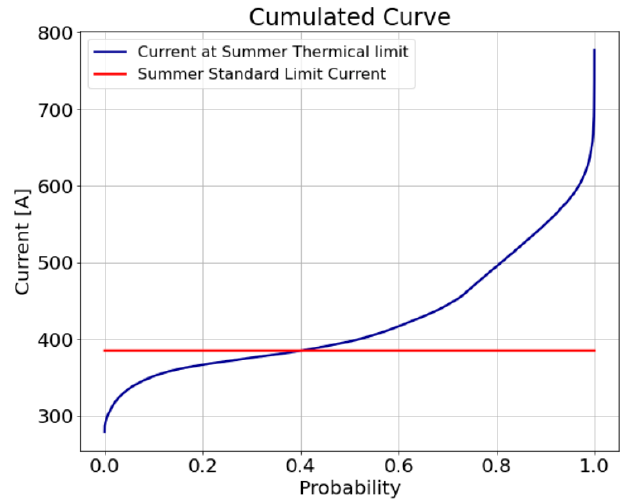
Figure 11. Cumulate current value for summer period of a generic HV Line.